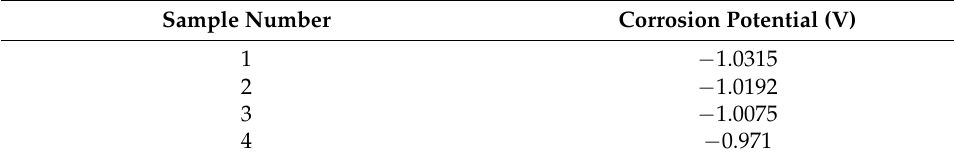
Figure 14. Polarization curves of the welds of the four samples. Table 4. Polarization curve analysis of the welds in the four samples. Table 4. Polarization curve analysis of the welds in the four